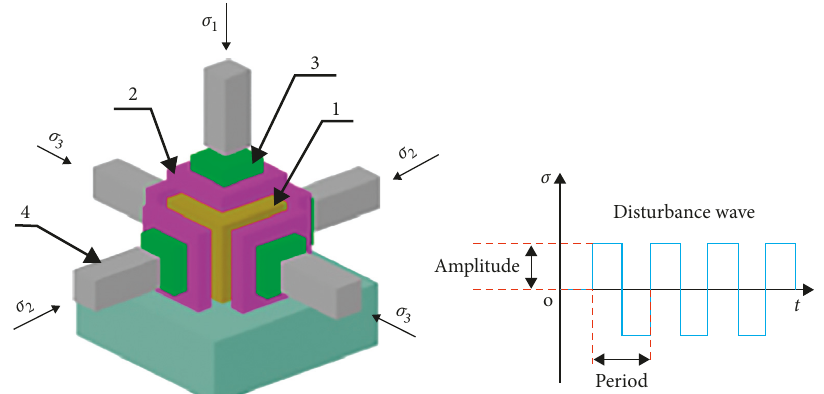
Figure 6: True-triaxial rockburst test schematic. (1) Rock specimen; (2) loading platen; (3) sensor; (4) loading bar (revised from